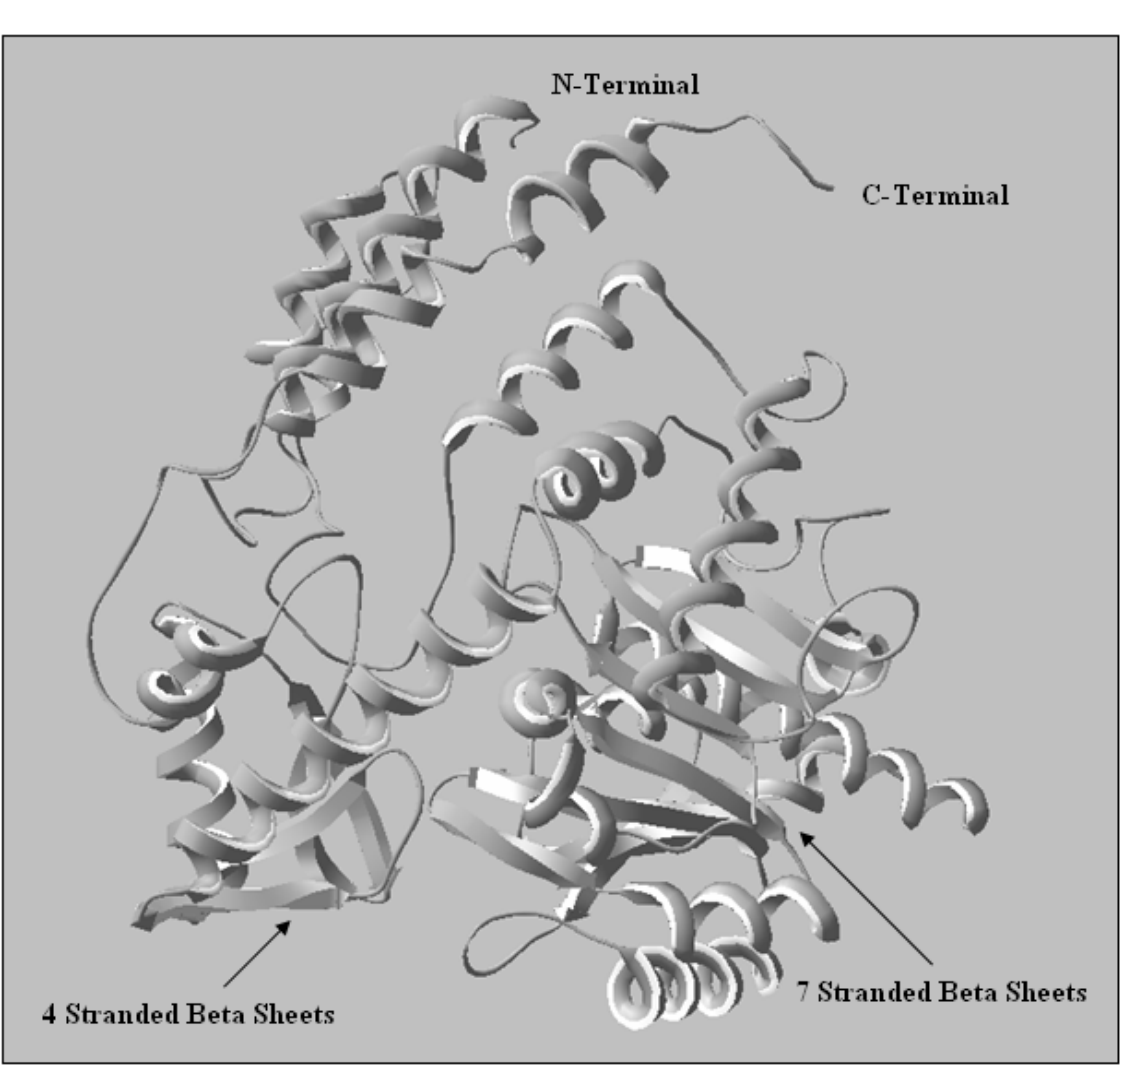
Figure 7: The structure of GAD 65 predicted with homology modelling. Only one chain of the homo-dimer is shown. N-terminal and C-terminal are indicated. The β -sheets and α -helices are visualized. The seven stranded β -sheet is surrounded by eight α -helices and the four-stranded β -sheet surrounded by three α